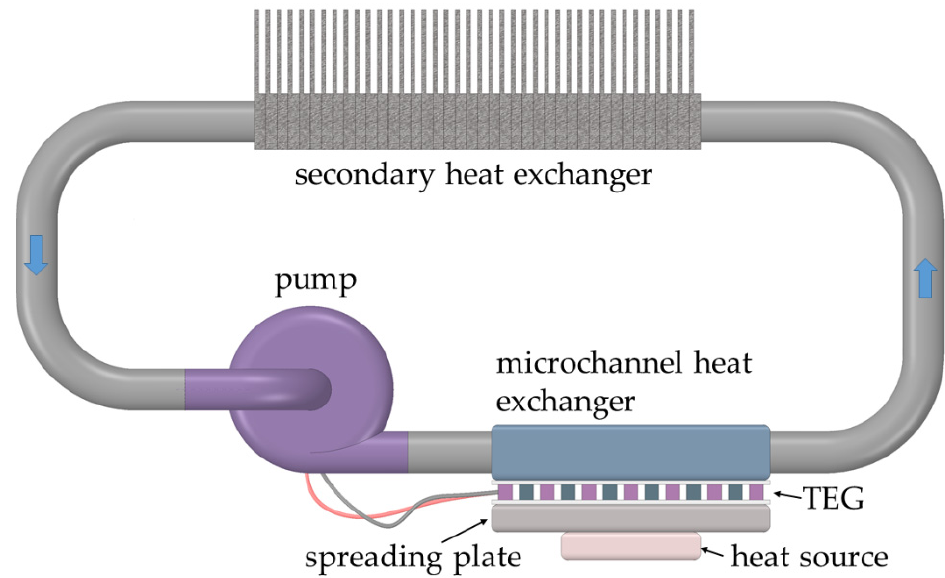
Figure 13. Self-cooling system with microchannel heat exchanger cooled TEG (Redrawn based on the figure provided in [79]).